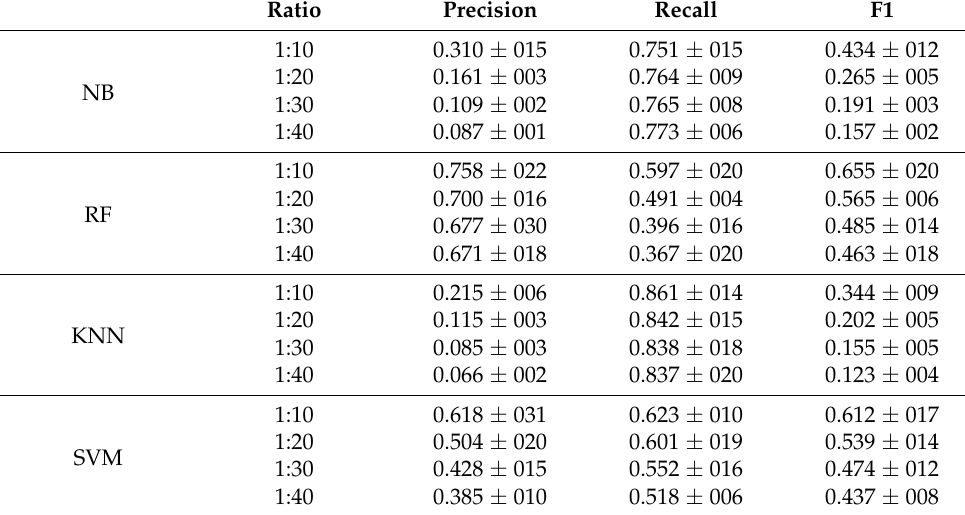
Table 2. Results of